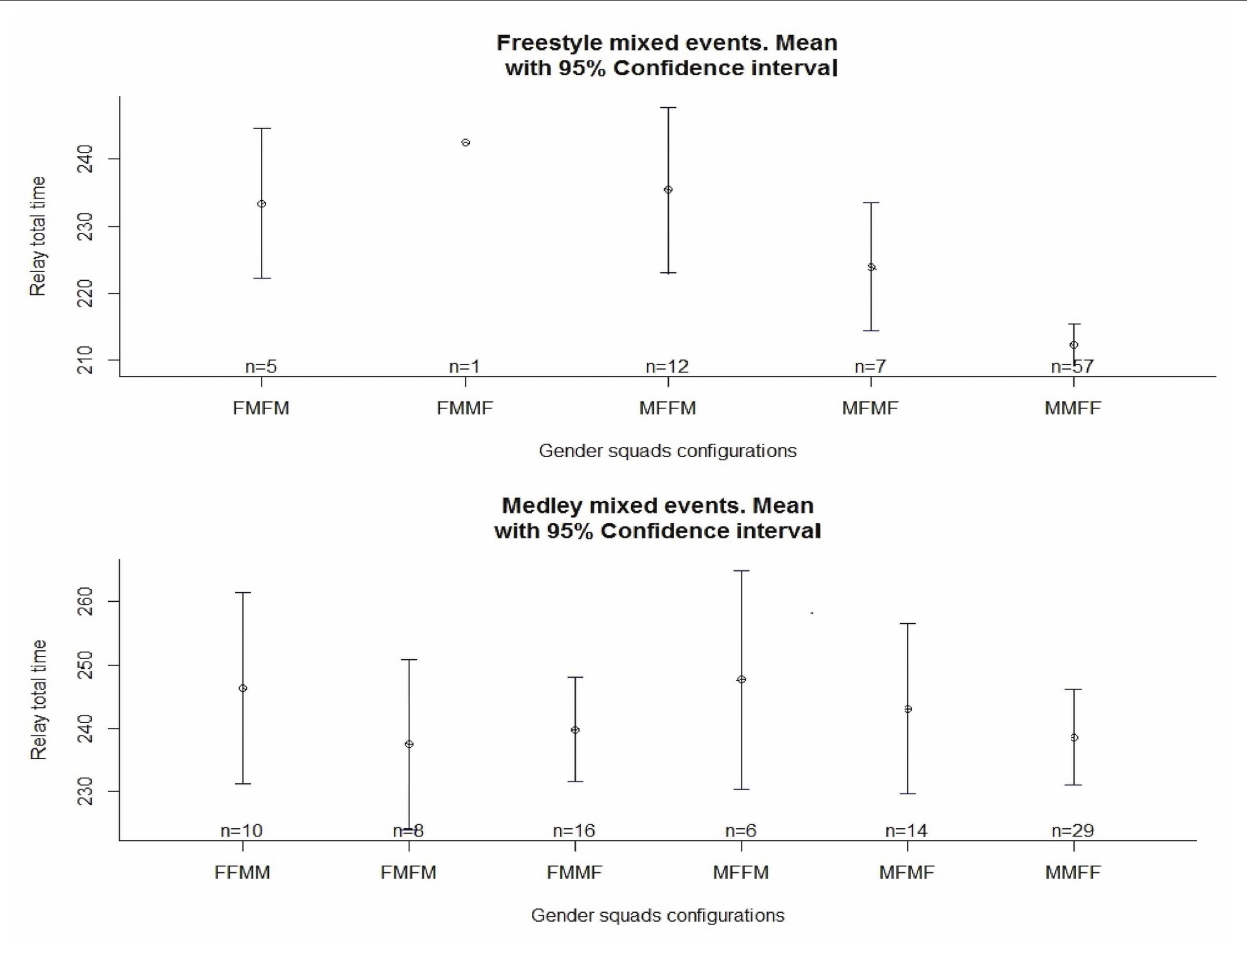
FIGURE 2 | Performance(s) in time (mean ± 95% confidence interval) of different gender squad’s configurations for the 4 × 100 m freestyle (above) and 4 × 100 m medley (below) relay events during 2015, 2017, and 2019 editions of 50 m World Swimming Championships. M: male and F: female.